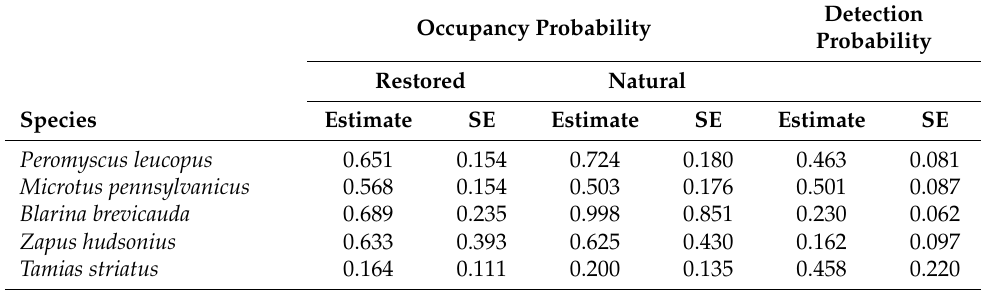
Table 3. Occupancy probabilities by wetland type and detection probabilities for five species captured in restored ( n = 14) and natural ( n = 12) wetlands throughout West Virginia, USA, from 2020–2021. Peromyscus maniculatus was omitted from occupancy modeling because it was discovered at each site, leading to poor occupancy